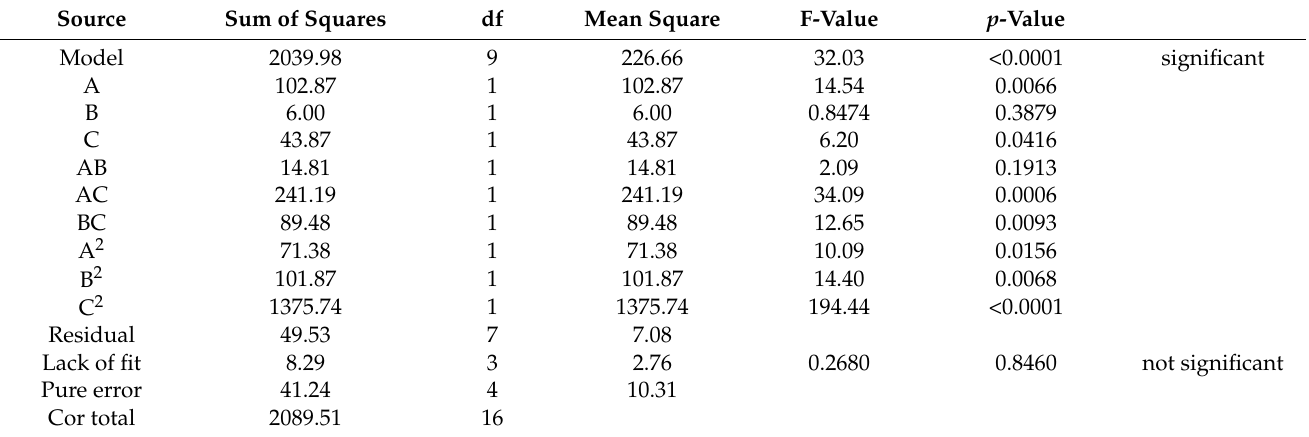
Table 4. Analysis of variance (ANOVA) for the quadratic model of the total SCFAs with a Box– Behnken design (BBD) experiment.